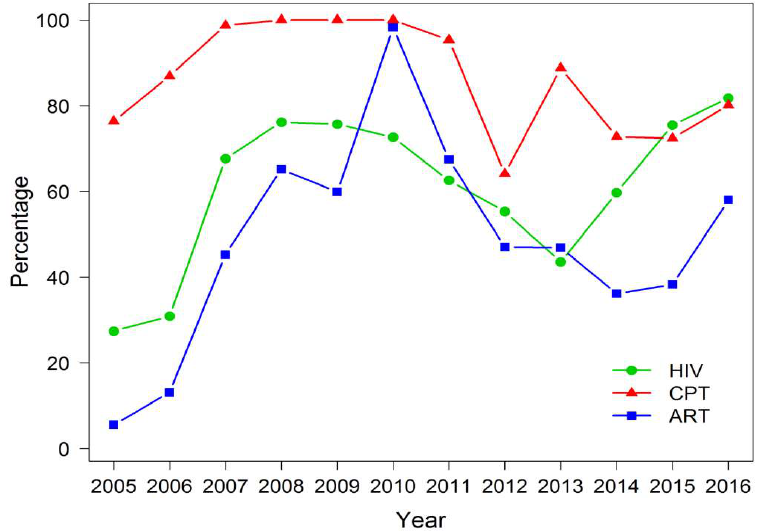
Figure 3. Performance of TB/HIV services including government and non-government sector (2005–2016). HIV: TB patients with known HIV status; CPT: HIV-positive TB patients who received CPT; ART: HIV-positive TB patients who received ART.